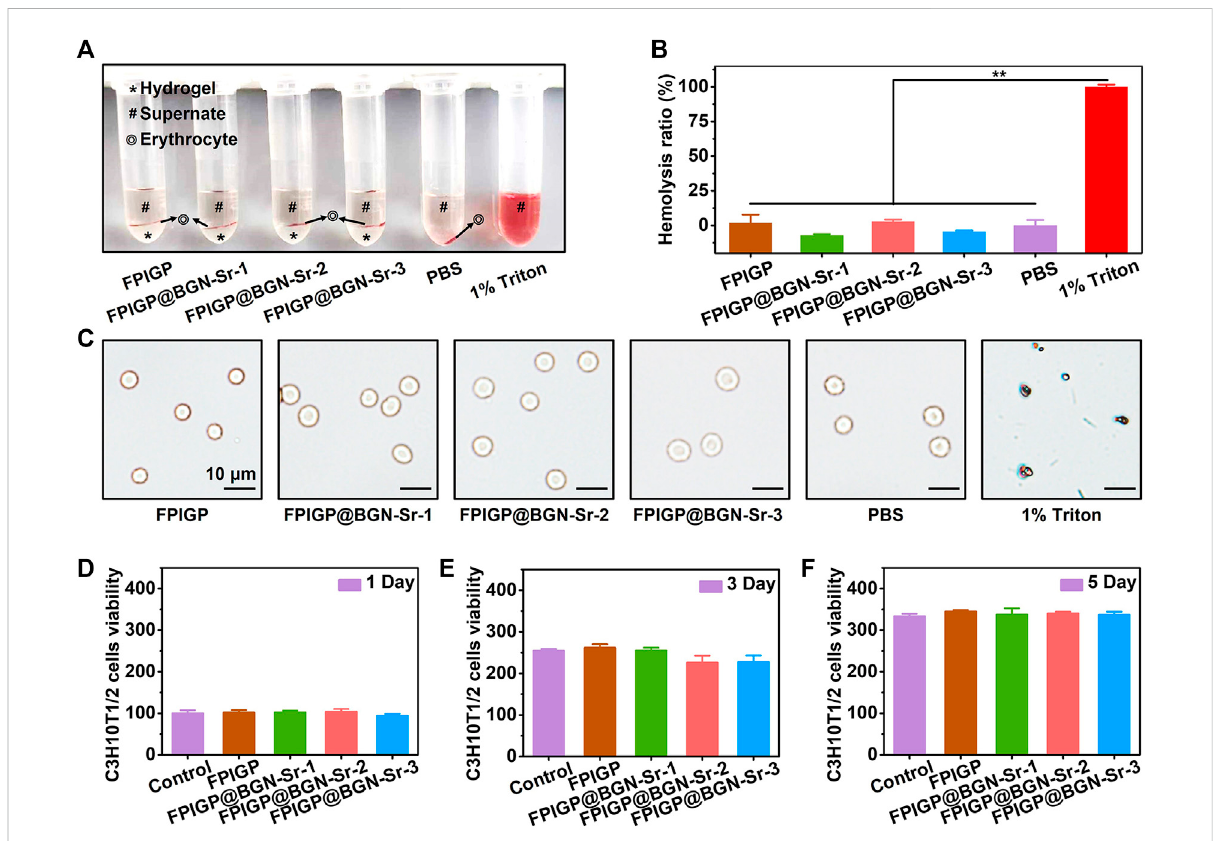
FIGURE 4 Biocompatibility evaluation of hydrogels. (A) The optical picture of erythrocytes after incubating with hydrogels. (B) The hemolysis ratio after incubating with hydrogels. (C) The morphology of erythrocyte after incubating with hydrogels. (D – F) The C3H10T1/2 cells viability after incubating with hydrogels for (D) 1 day, (E) 3 days and (F) 5